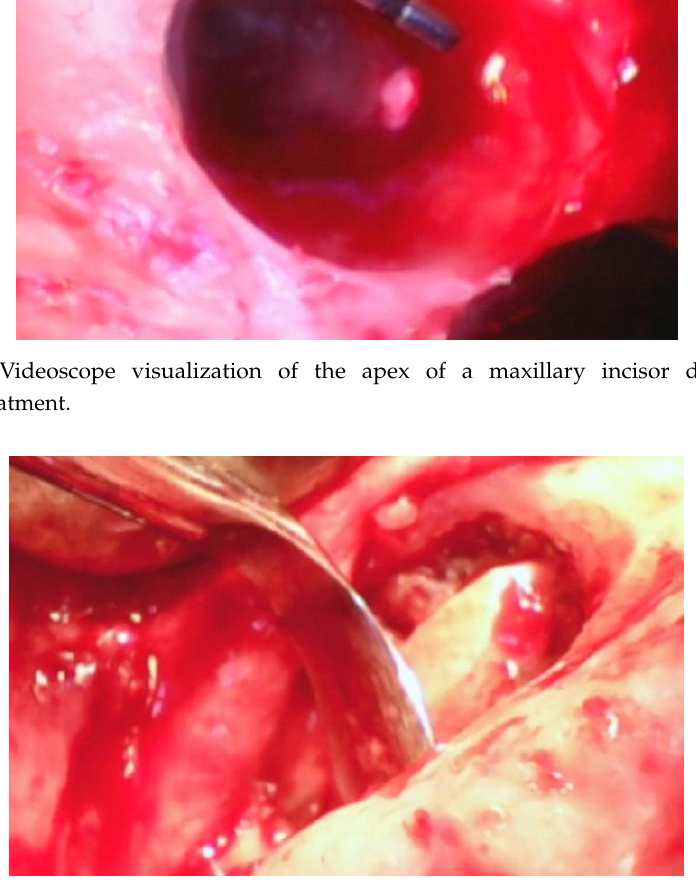
Figure 11. Videoscope visualization of a lateral window access for sinus bone grafting in preparation for placing implants.